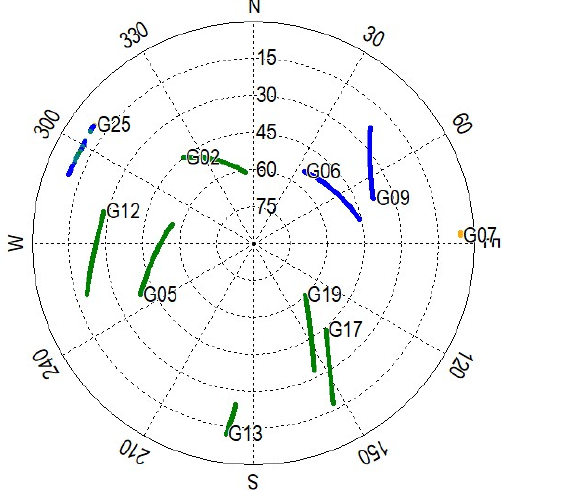
Figure 4. The number of the observed Global Positioning System ( GPS) and GLObal NAvigation Satellite System (GLONASS) satellites ( top ) and PDOP values ( bottom ).